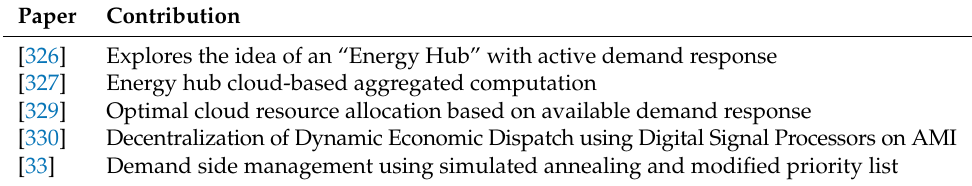
Table 12. SmartGrid & Renewable Integration state-of-the-art studies.